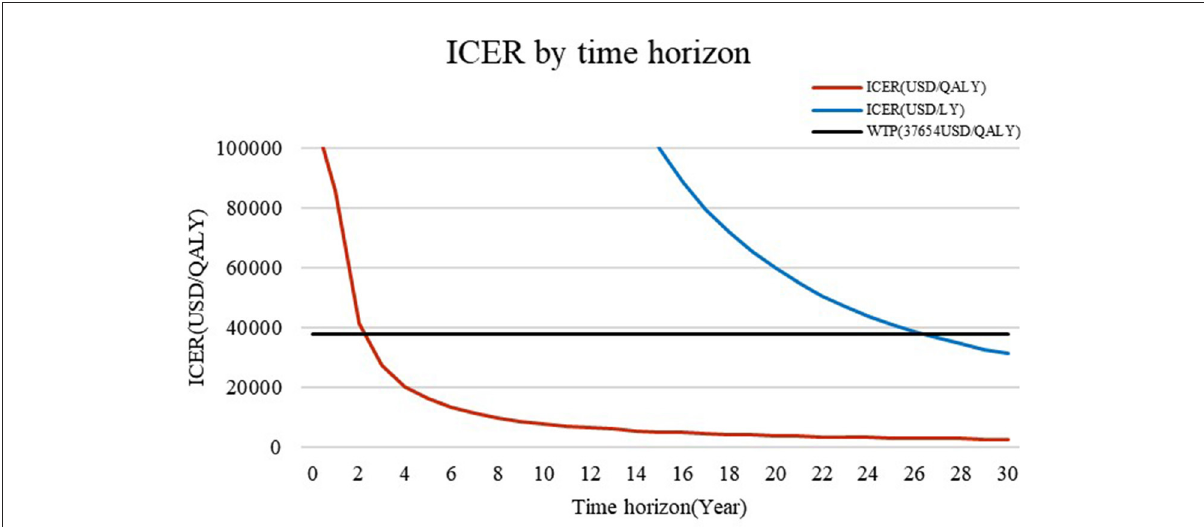
FIGURE2 ICER based on different time horizons. When the time horizon is < 3 years, the ICER is higher than the WTP of US $37,654/QALY. However, if the quality of life is not considered, PFO is cost-effective for those with a life expectancy of > 26 years.